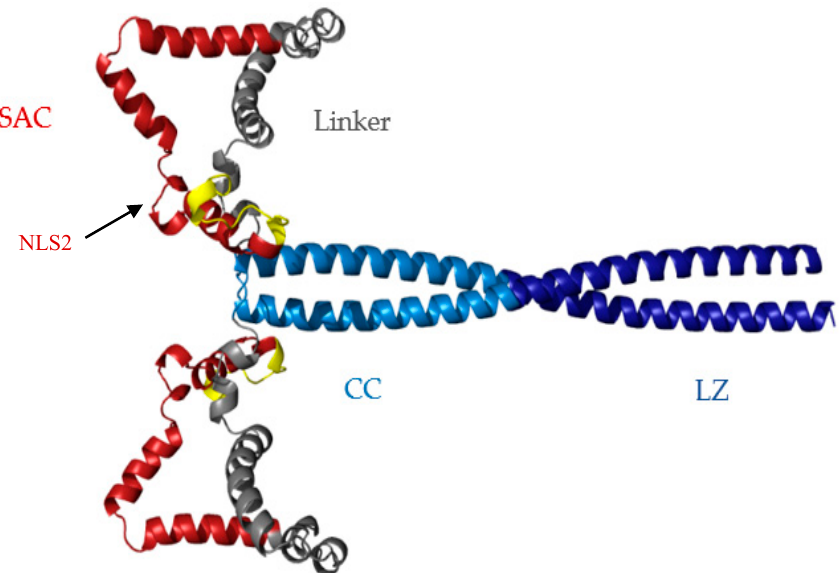
Figure 7. GalaxyWEB model of cl-Par-4 at acidic pH. The N-terminal residues are yellow, the selective for apoptosis induction in cancer cells (SAC) domain with nuclear localization signal 2 (NLS2) is red, the linker region is gray, and coiled coil (CC) is blue. Darker blue is the leucine zipper (LZ) region of the CC. The position of NLS2 is also indicated.